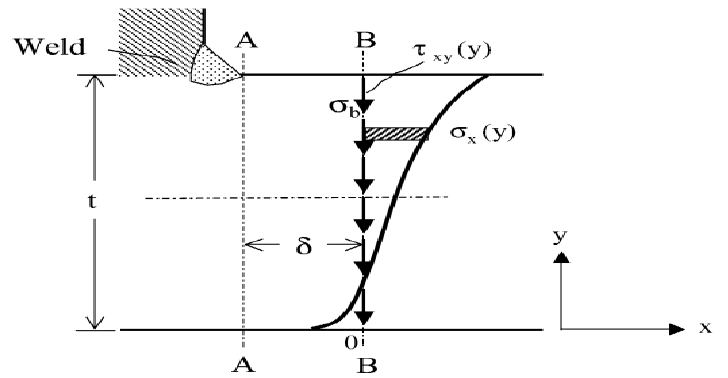
Figure 1. Stress state in the weld toe.